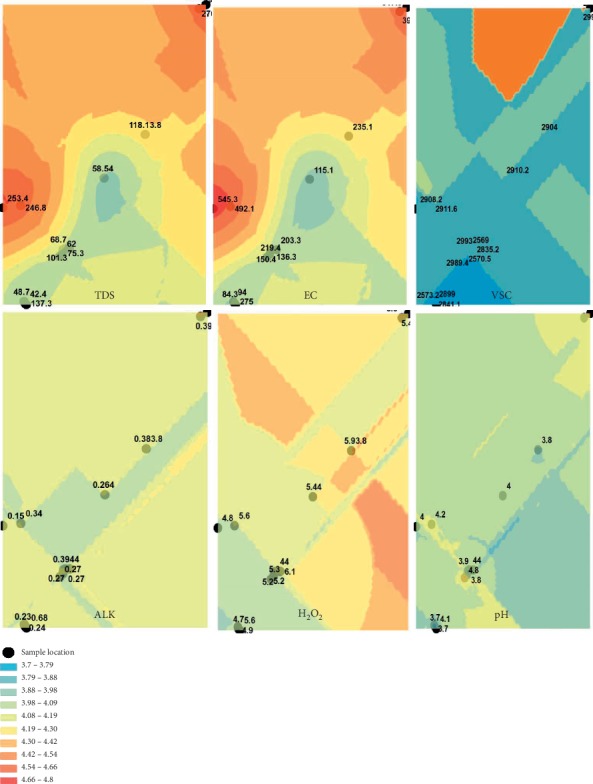
Spatial distribution of various honey sample parameters in Southwest Nigeria indicated by black spots (TDS, total dissolved solids; EC, electrical conductivity; VSC, viscosity; ALK, alkaloids; H2O2, hydrogen peroxide; pH).